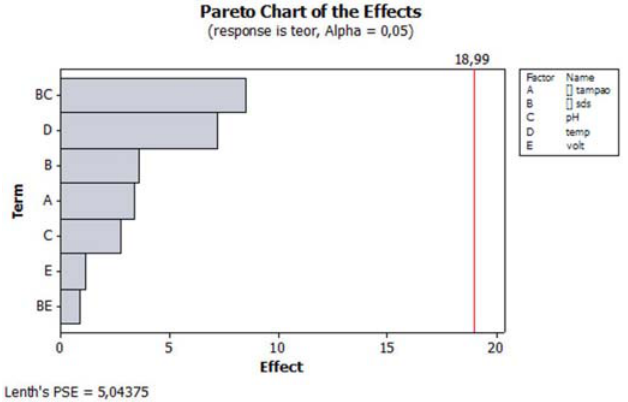
FIGURE 3 - Robustness of MEKC method (Pareto chart of the effects – []tampão =concentration of boric acid, []sds = concentration of the surfactant, pH = pH of the buffer solution, temp = temperature of the analysis, volt = applied voltage of the